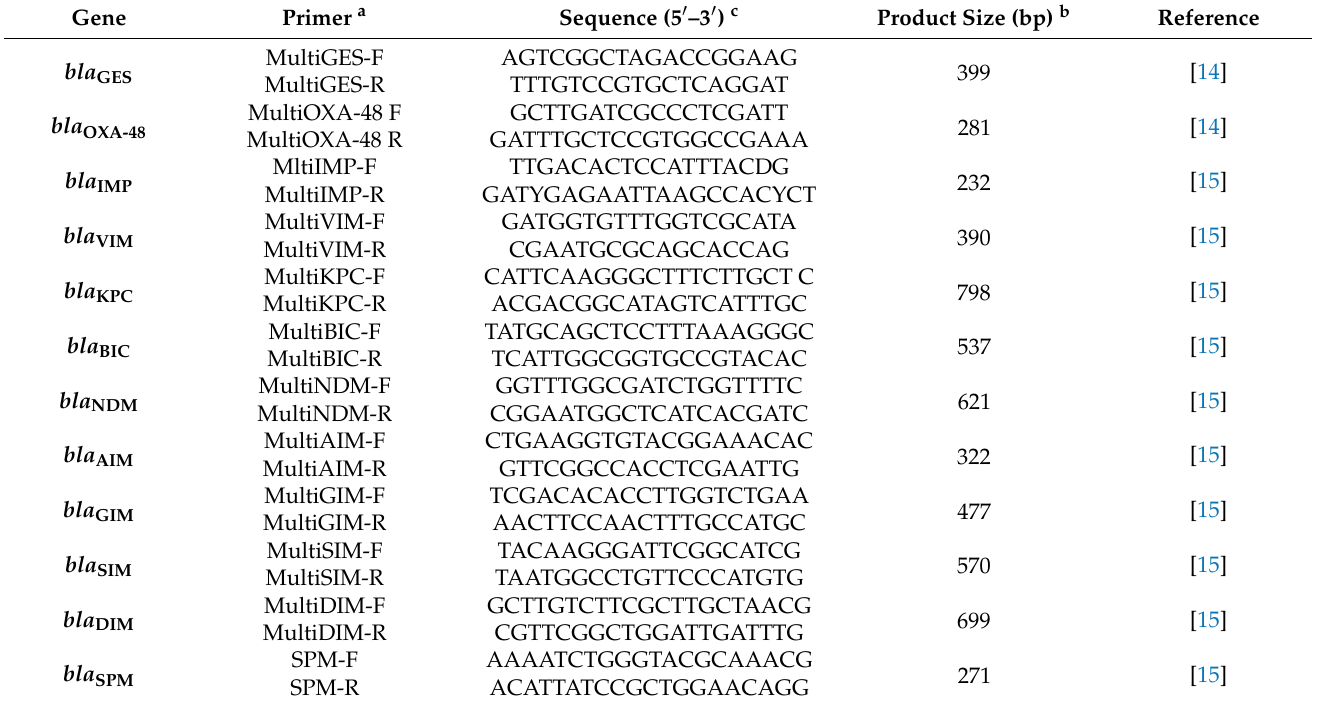
Table 1. Oligonucleotides used in this